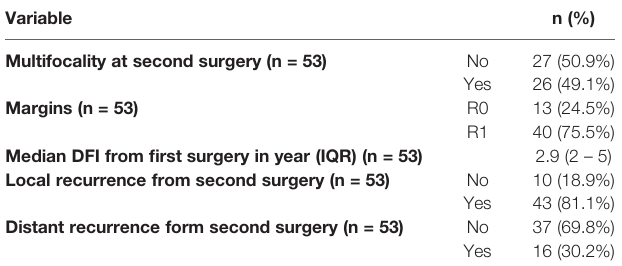
TABLE 2 | Recurrent tumour characteristics.